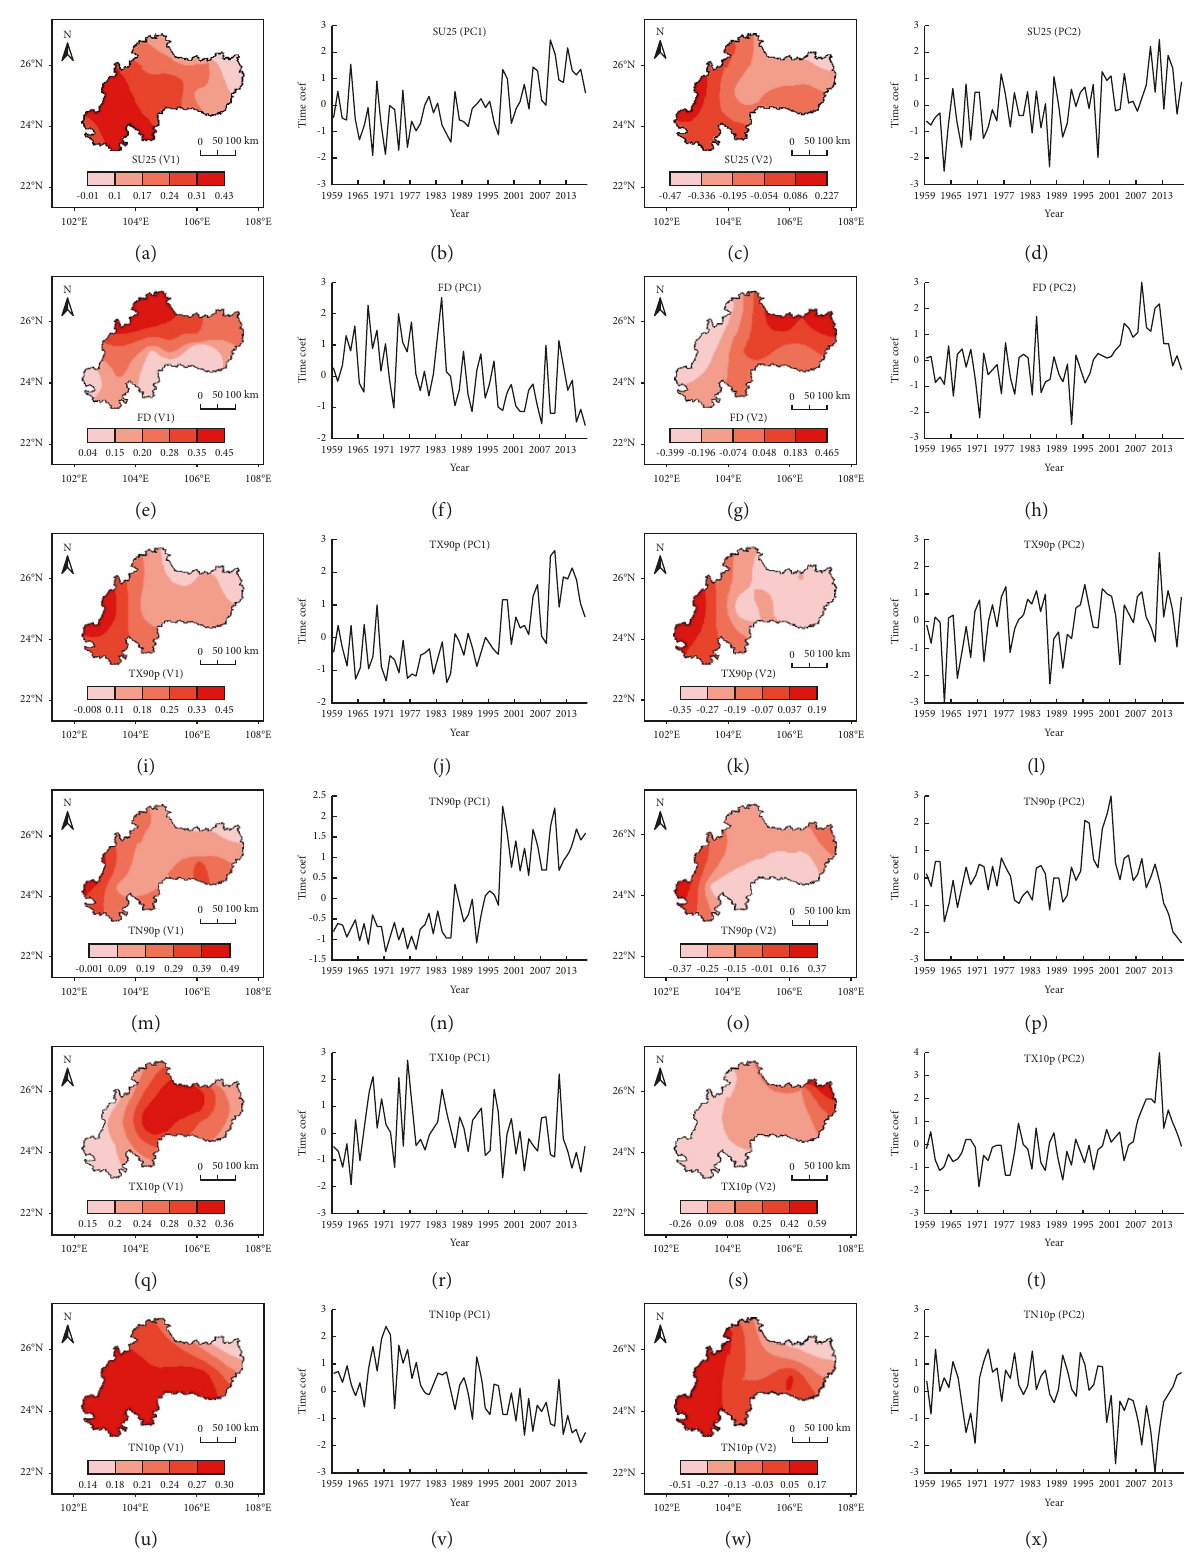
Figure 5: The first and second eigenvectors and their time coefficients of extreme temperature frequency